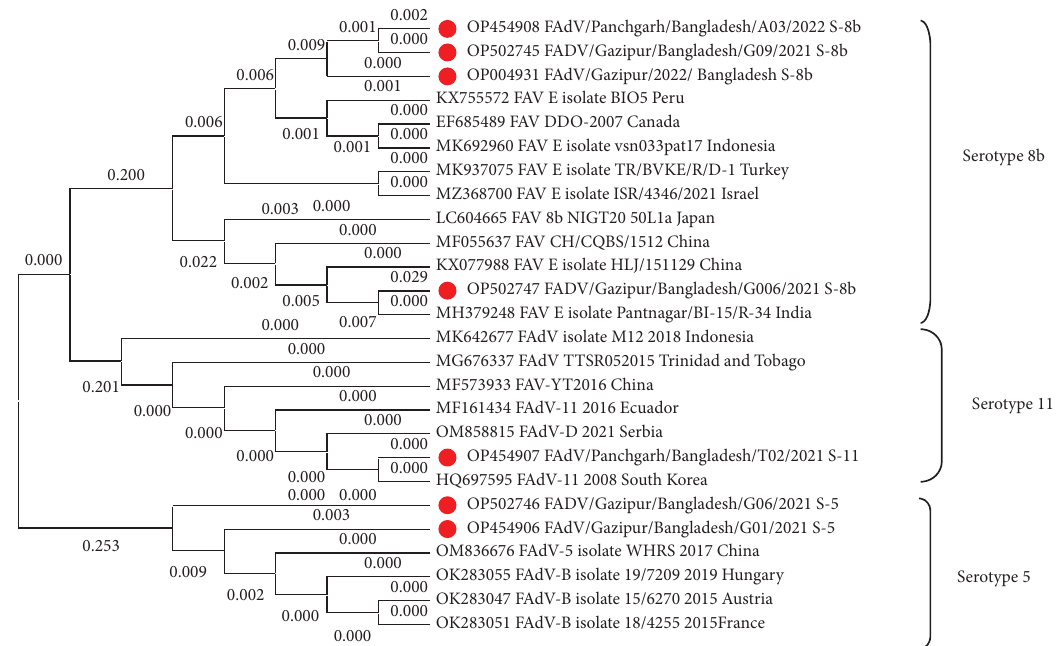
Figure 4: Evolutionary relationships of fowl adenoviruses. Evolutionary analyses were conducted in MEGA11. Te evolutionary history was inferred using the neighbor-joining method. Te evolutionary distances were computed using the maximum composite likelihood method and are in the units of the number of base substitutions per site. Viruses sequenced in this study were marked with red